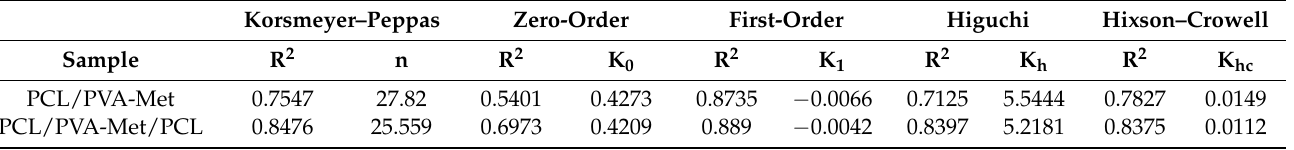
Table 2. In vitro drug release kinetics of the PCL/PVA-Met and PCL/PVA-Met/PCL